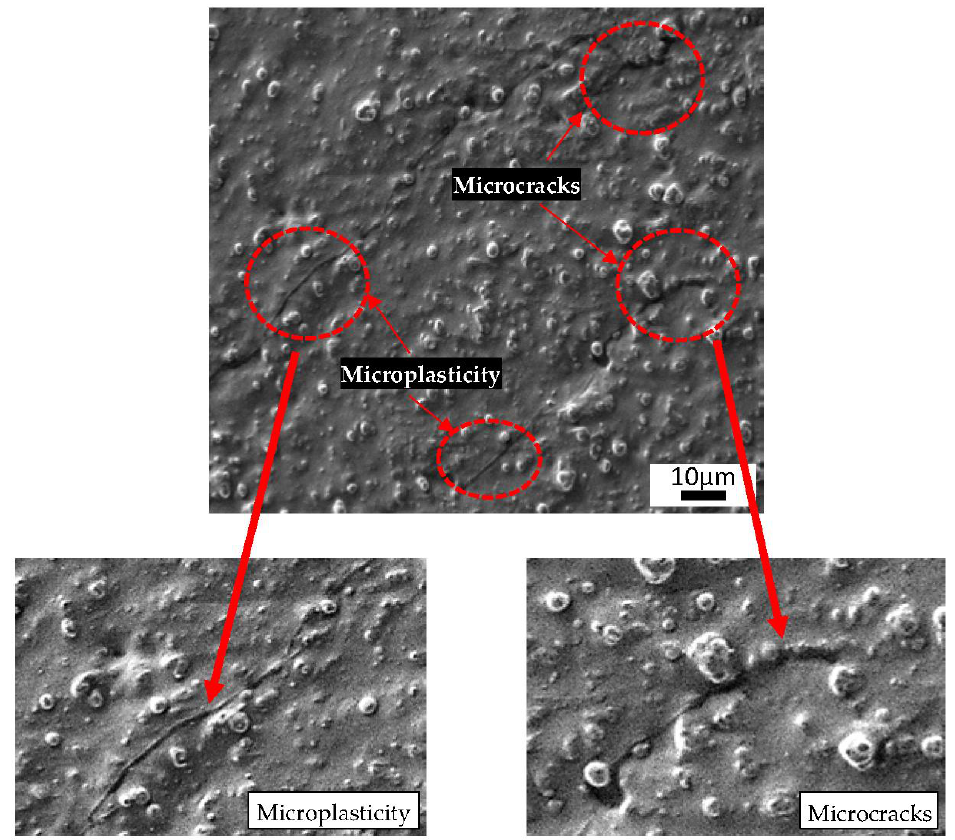
Figure 6. FESEM images of an MRE sample at maximum strain before breakage.